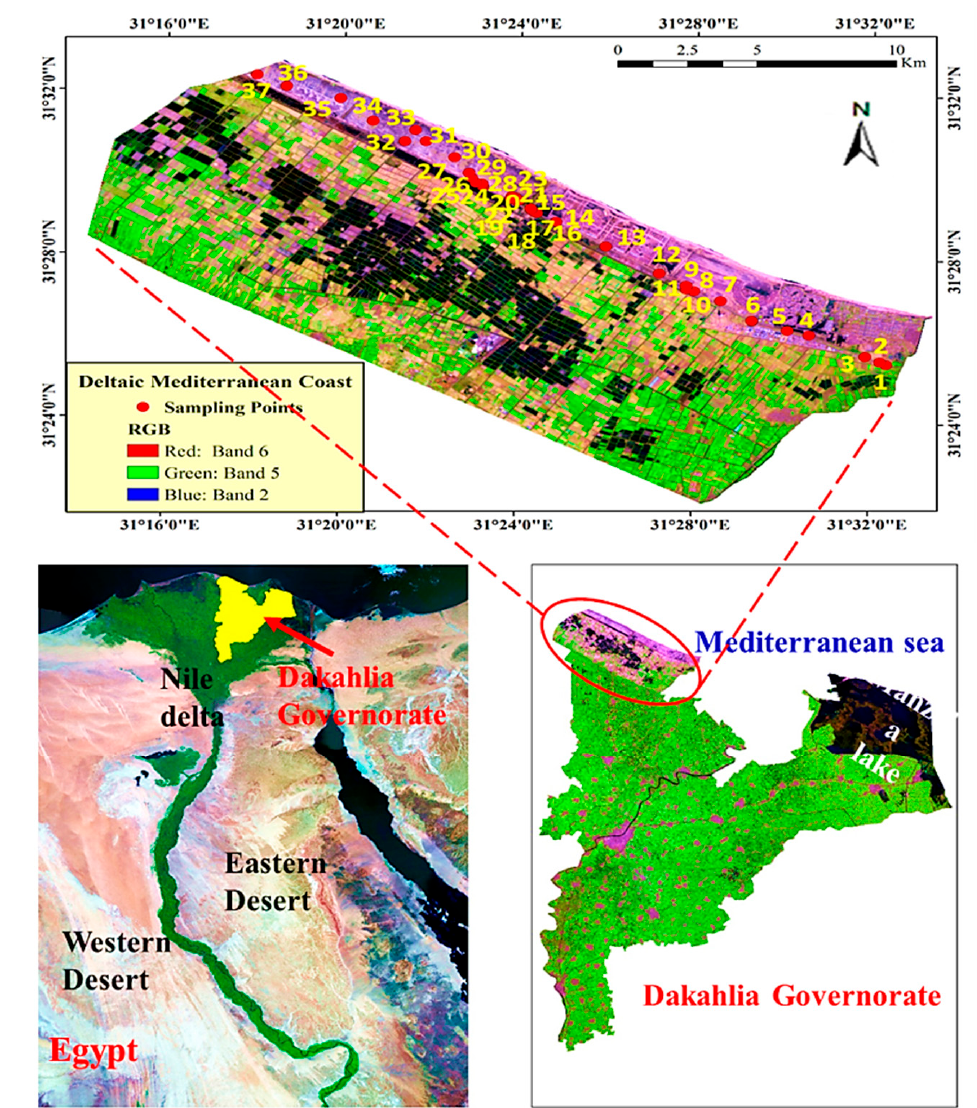
Figure 1. Map of Egypt showing Dakahlia Governorate and location of the studied sites (1–37) along the Nile Delta coast (Dakahlia Governorate).